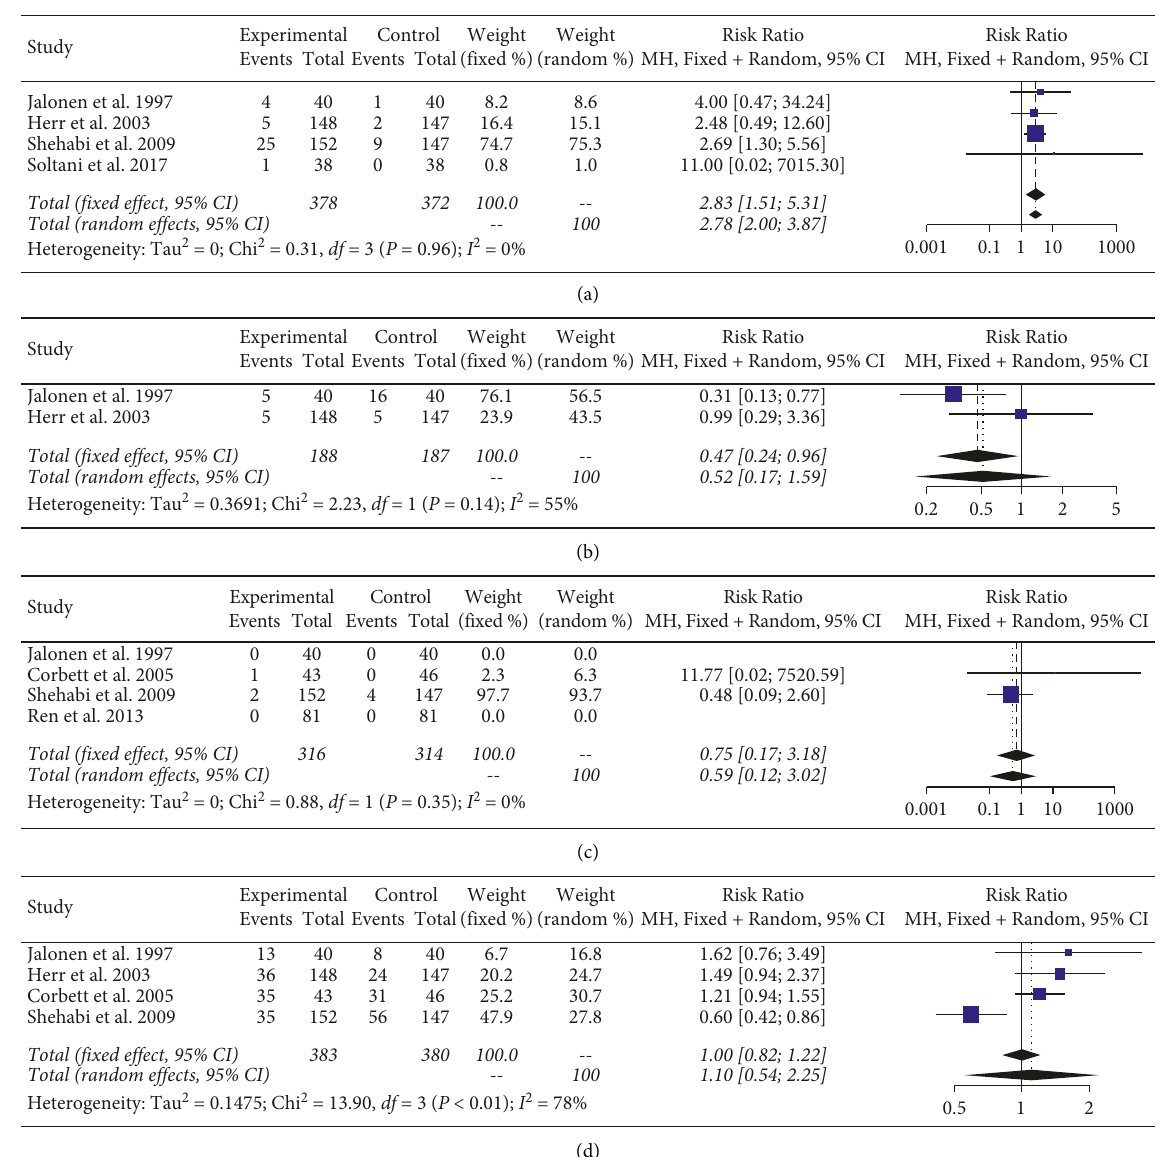
Figure 4: Meta-analysis of (a) bradycardia, (b) tachycardia, (c) mortality, and (d)